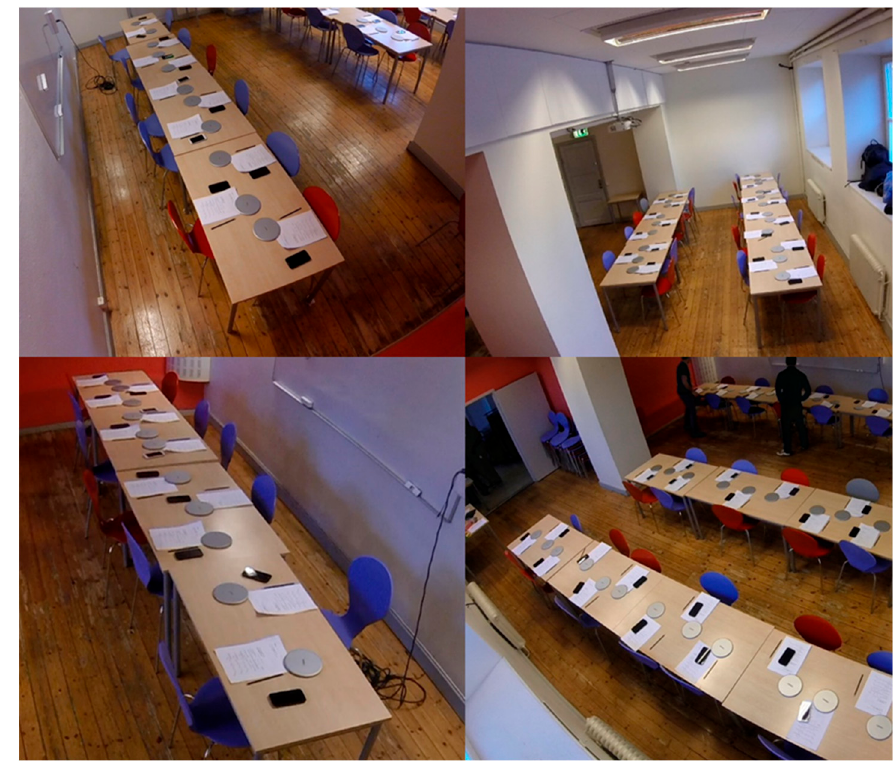
Figure 3. Placement of the cameras recording students during their lunches.